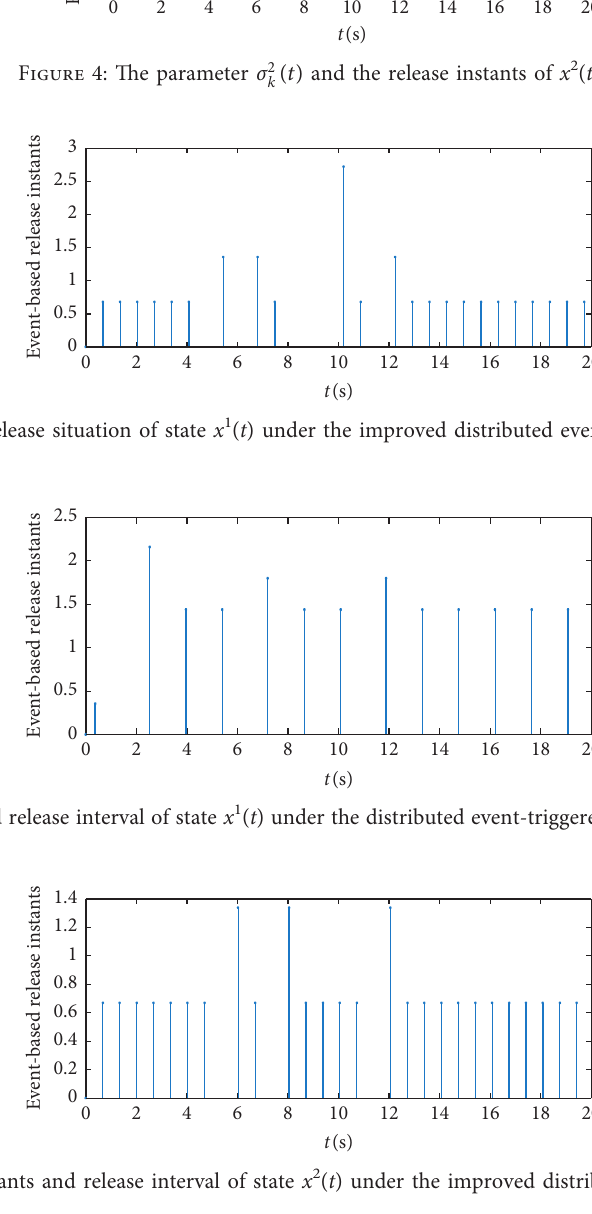
Figure 7: The release instants and release interval of state x 2 ( t ) under the improved distributed event-triggered